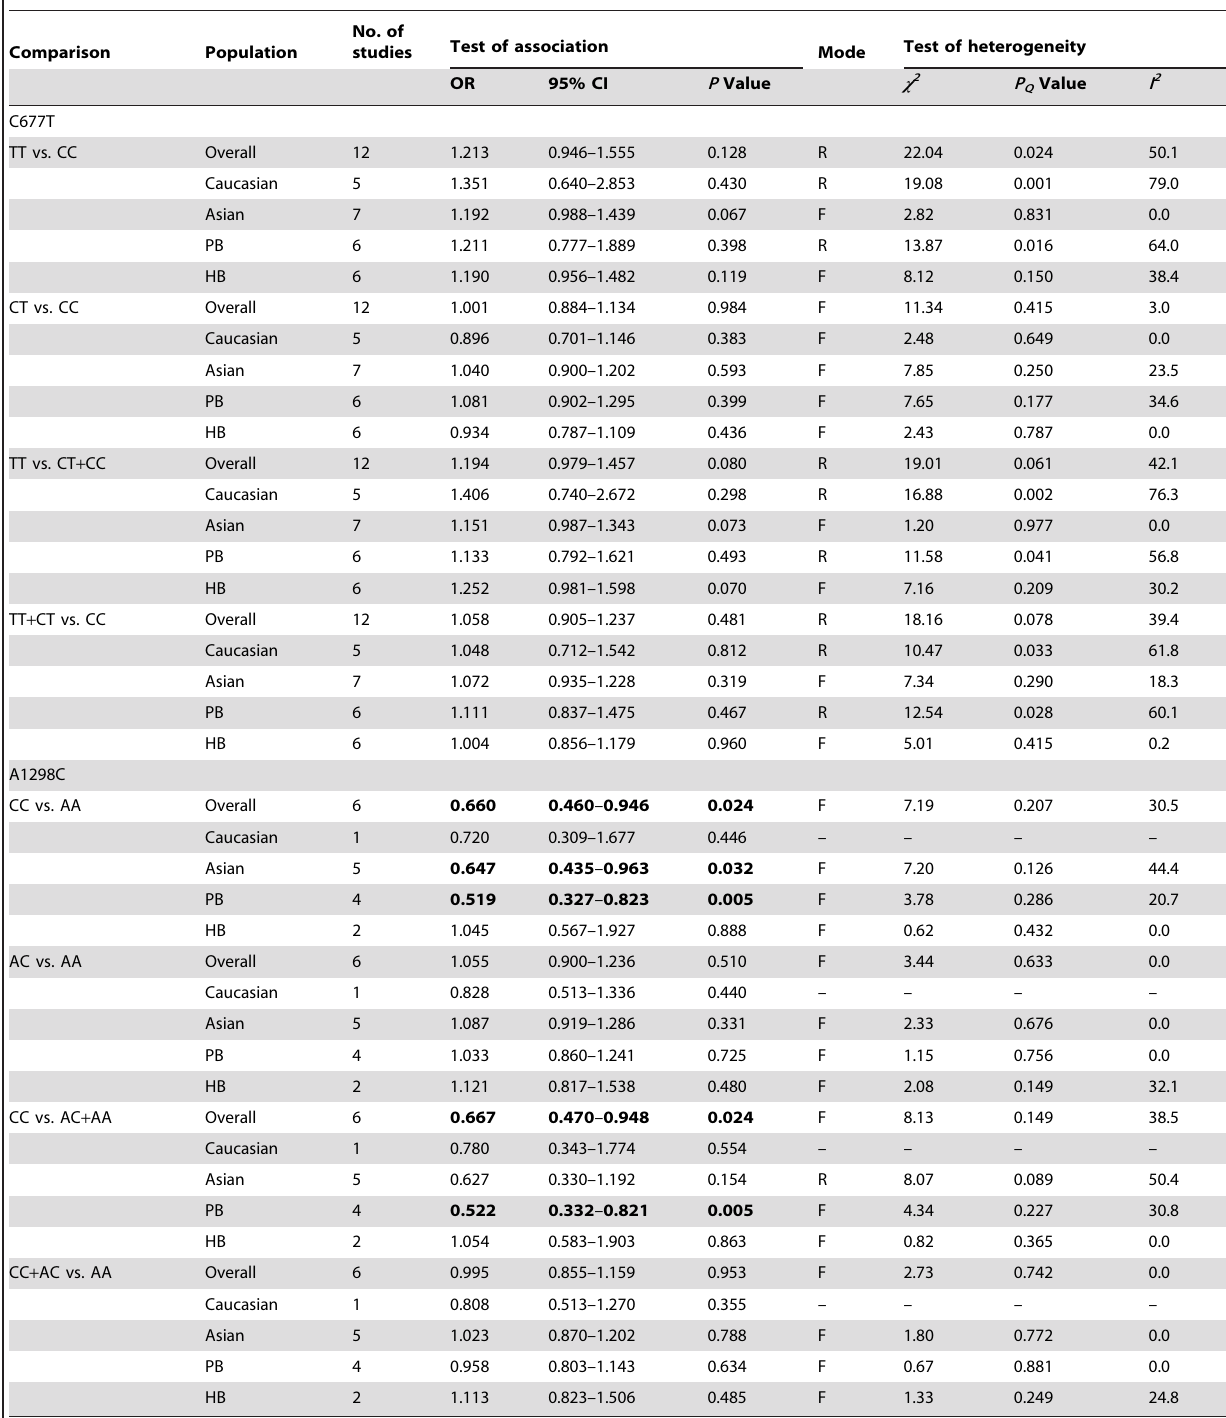
Table 3. Meta-analysis of the MTHFR gene polymorphisms on HCC